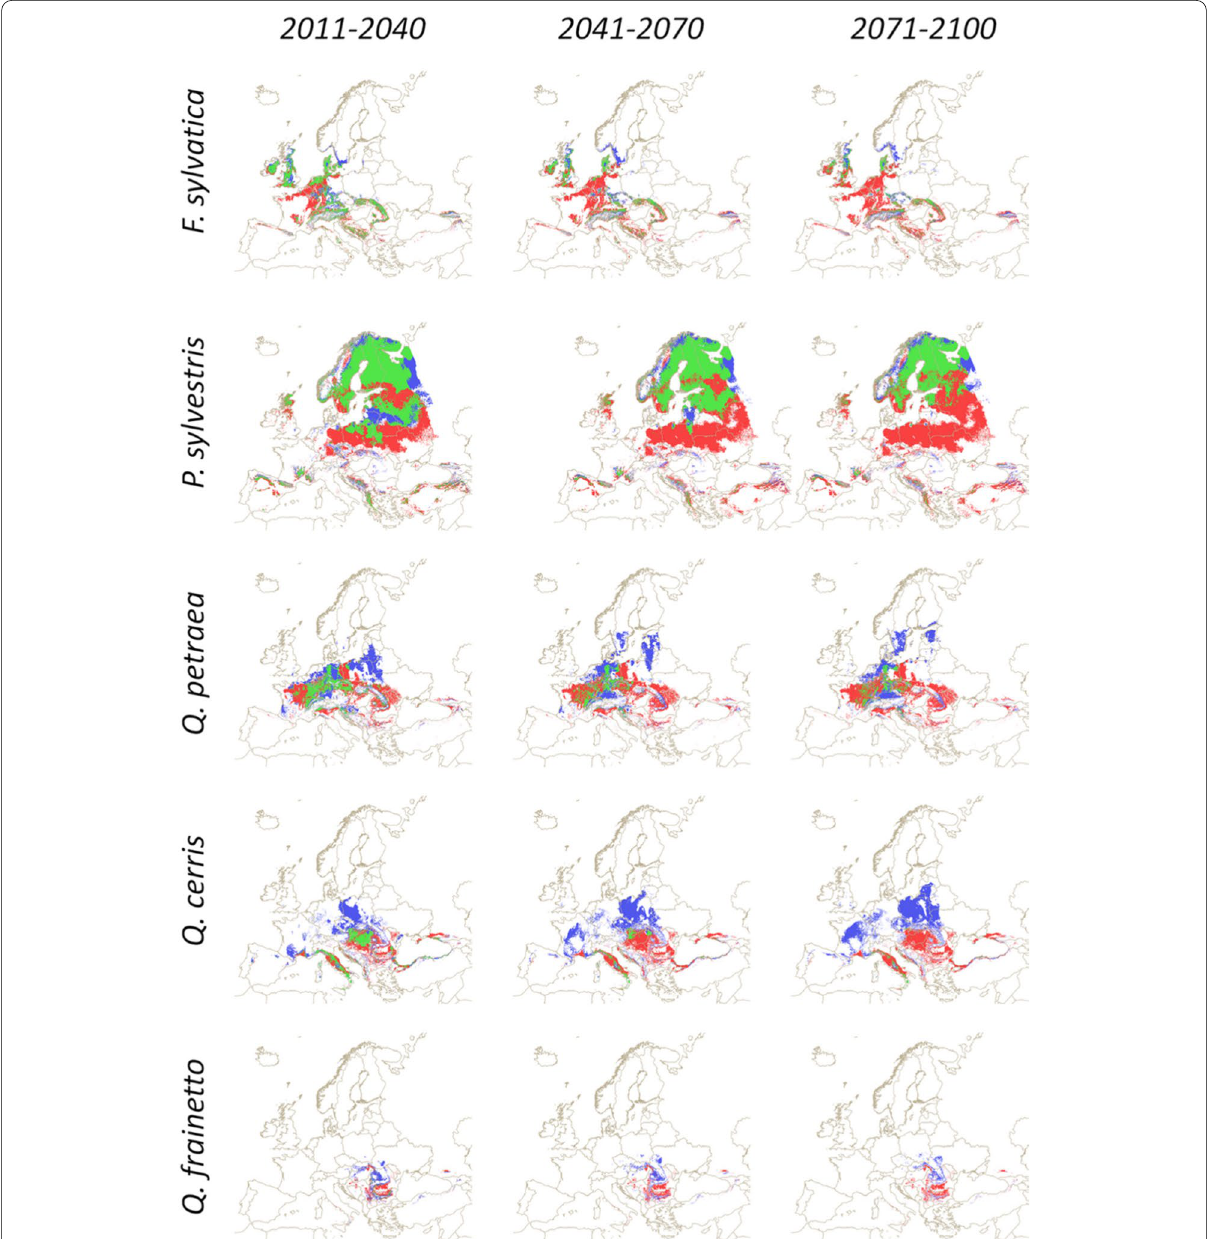
Fig. 3 Projected potential climate envelope shift of some selected tree species under the emission scenario RCP 4.5. Green areas indicate identical areas under current and future predictions, blue indicates areas that are potentially occupied, and red indicates areas that are potentially